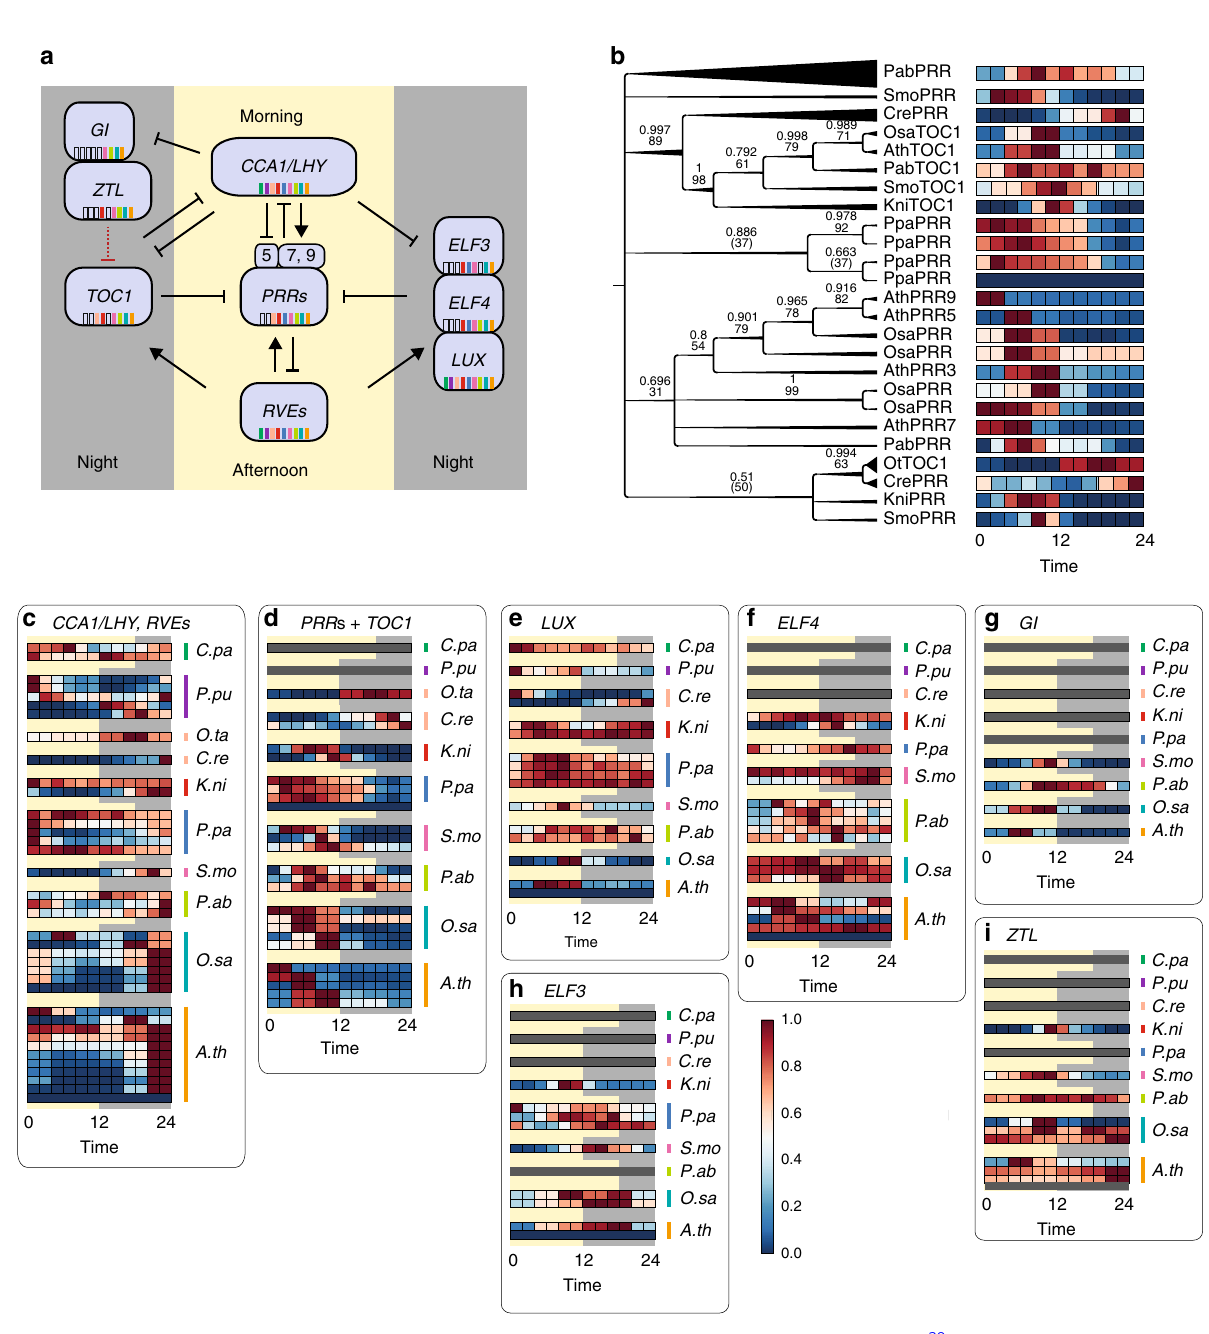
Fig. 5 Analysis of clock core component genes. a Simpli fi ed A . thaliana circadian clock model (modi fi ed from ref. 39 ). The colored bars within the gene families indicate in which plant clades a given gene family is present. The red dashed arrow indicate regulation at protein level. b Phylogenetic tree constructed on Bayesian inference of phylogeny. The numbers at the nodes indicate posterior probabilities (above) and bootstrap values (below). The gene annotation was based on 69 . The single heatmaps represent the 0 – 1-scaled expression pro fi les of each gene of the PRR family. Scaled expression pro fi les of genes belonging to c CCA1 / LHY / RVEs , d PPRs , e LUX , f ELF4 , g GI , h ELF3 , and i ZTL . The scaled expression pro fi les are showing the expression for each